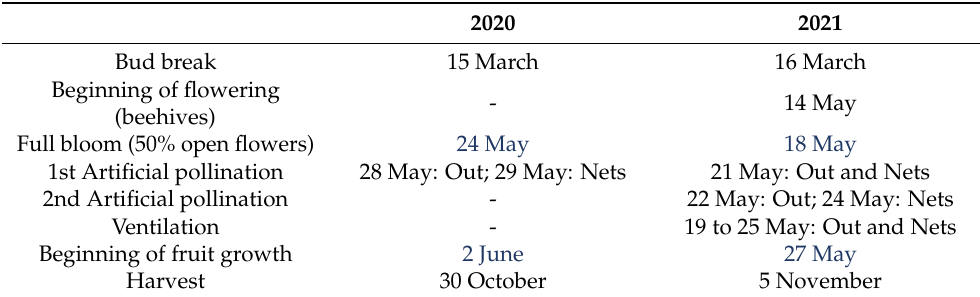
Table 1. Dates of some phenological stages and crop management procedures, during 2020 and 2021 growing periods, in outside (Out) and under the nets (Nets)